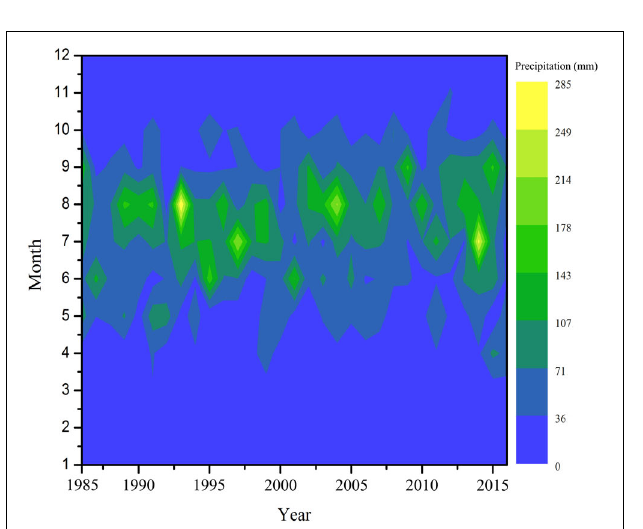
FIGURE 5 | Hourly rainfall from 1:00 on July 16, 2019 to 24:00 on August 29, 2019 in Guyuan City (A) ; From 10:00 to 22:00 on July 21, 2019, every 5 min rainfall of the rain event in Guyuan City (B)